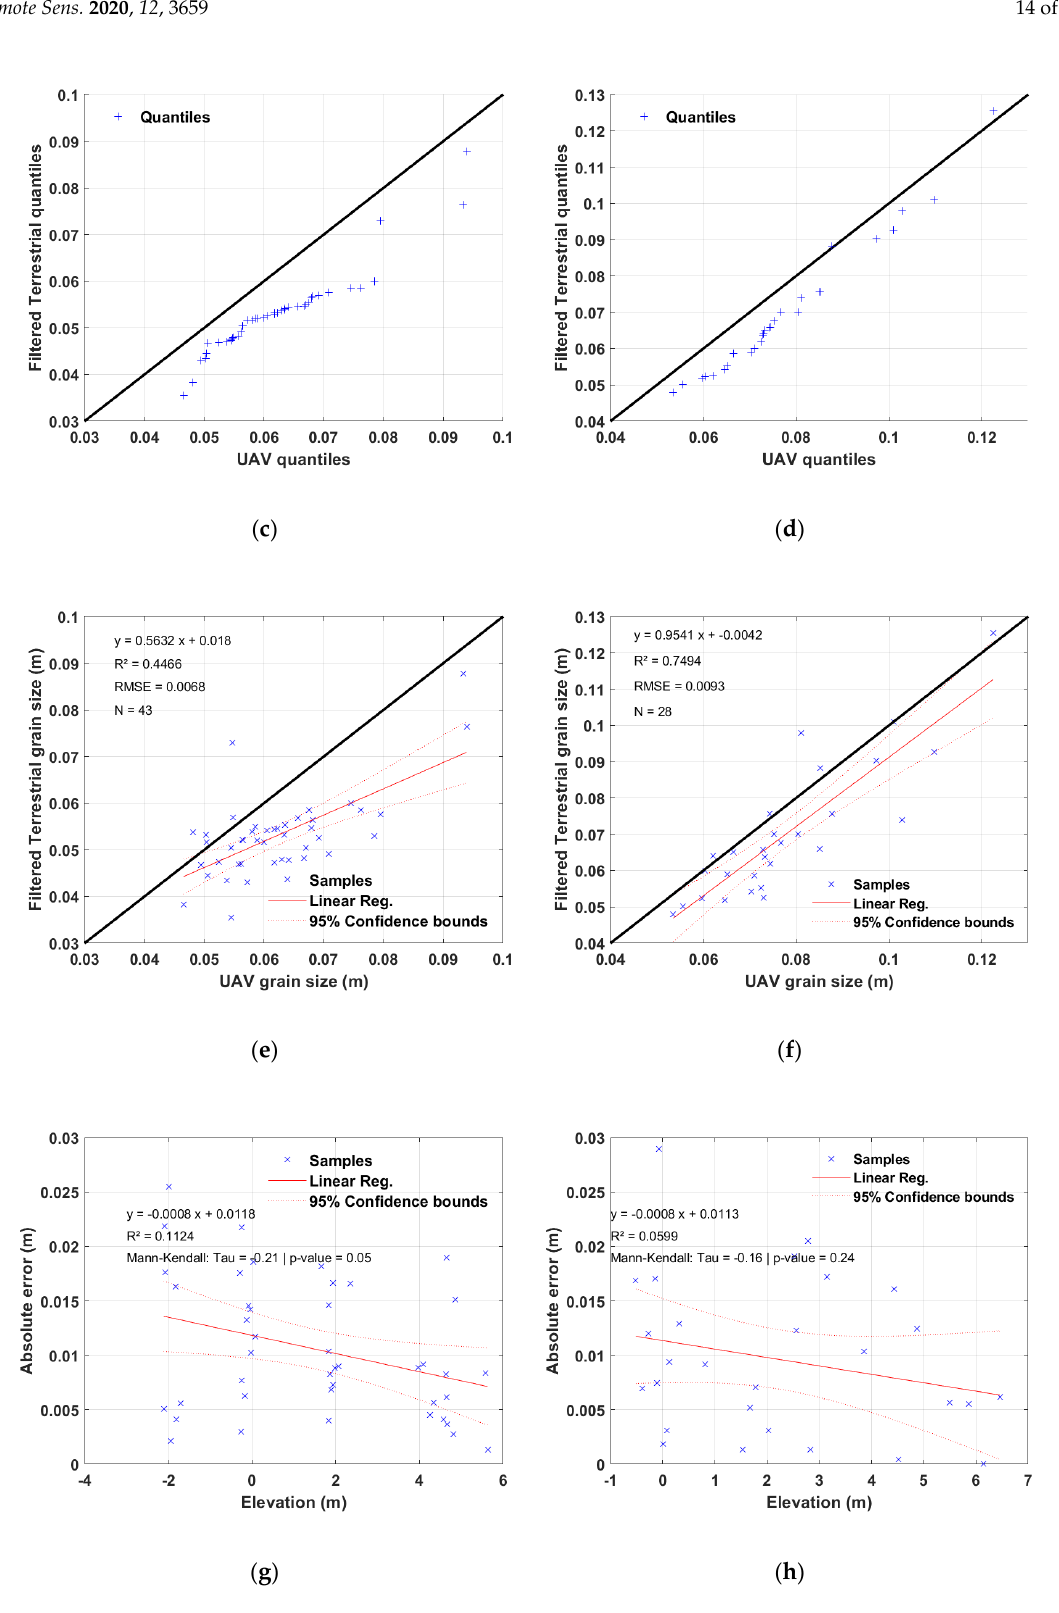
Figure 11. Clast size mapping validation results. ( a , b ): Comparison of the average grain size as measured on the terrestrial samples (blue “*” symbols), the filtered terrestrial samples (red “o” symbols) and by the UAV samples (black “ + ”symbols at ( a ) Etretat and ( b ) Hautot-sur-Mer. Colored envelops present the standard deviation intervals. Compared mean values of the UAV and filtered terrestrial distributions at ( c ) Etretat and ( d ) Hautot-sur-Mer. Quantile–Quantile diagrams comparing the UAV and filtered terrestrial distributions at ( e ) Etretat and ( f ) Hautot-sur-Mer. Absolute error on the pebble size measurements as a function of the elevation at ( g ) Etretat and ( h )